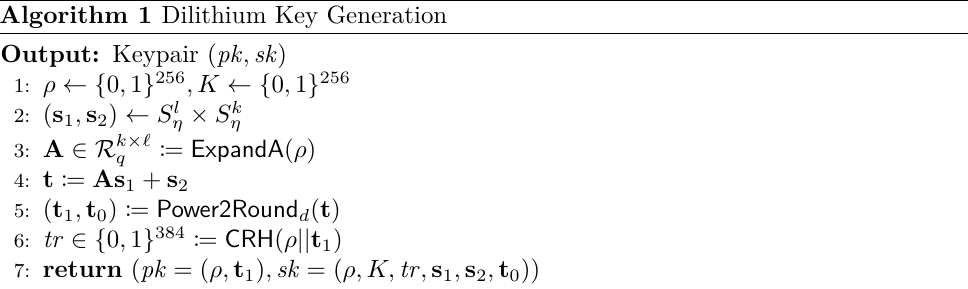
Algorithm 1 Dilithium Key